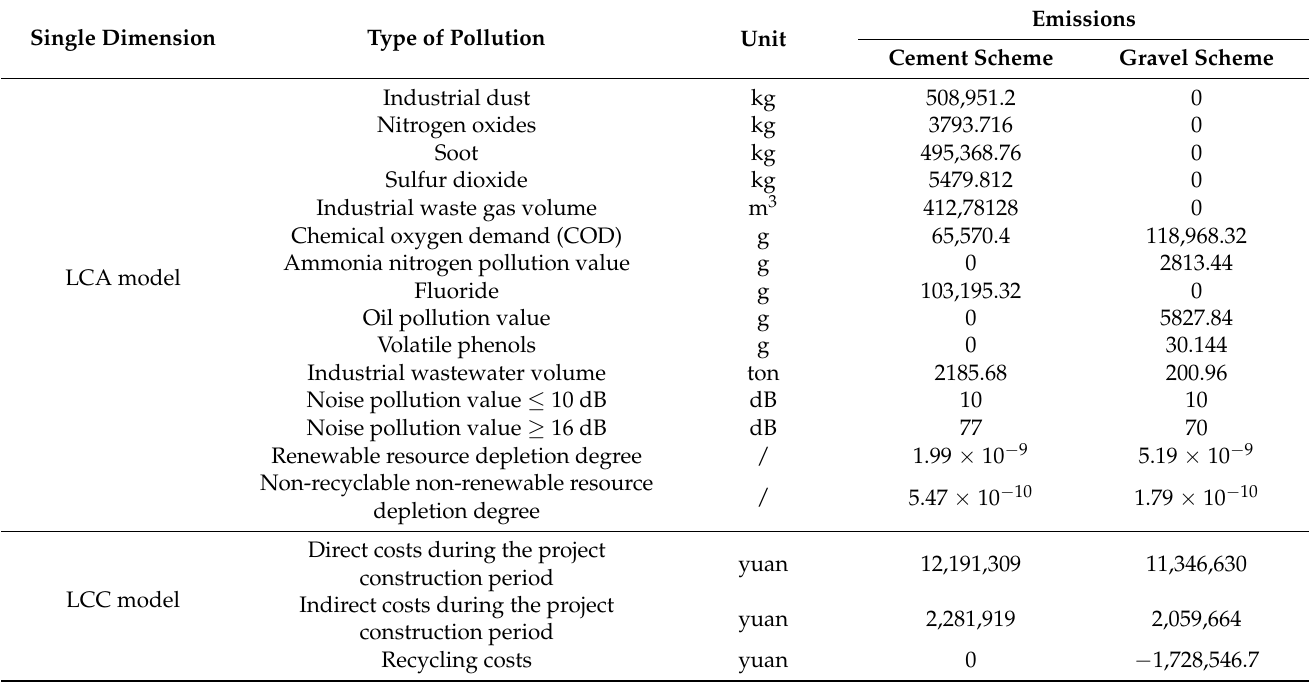
Table 5. Cement scheme and gravel scheme